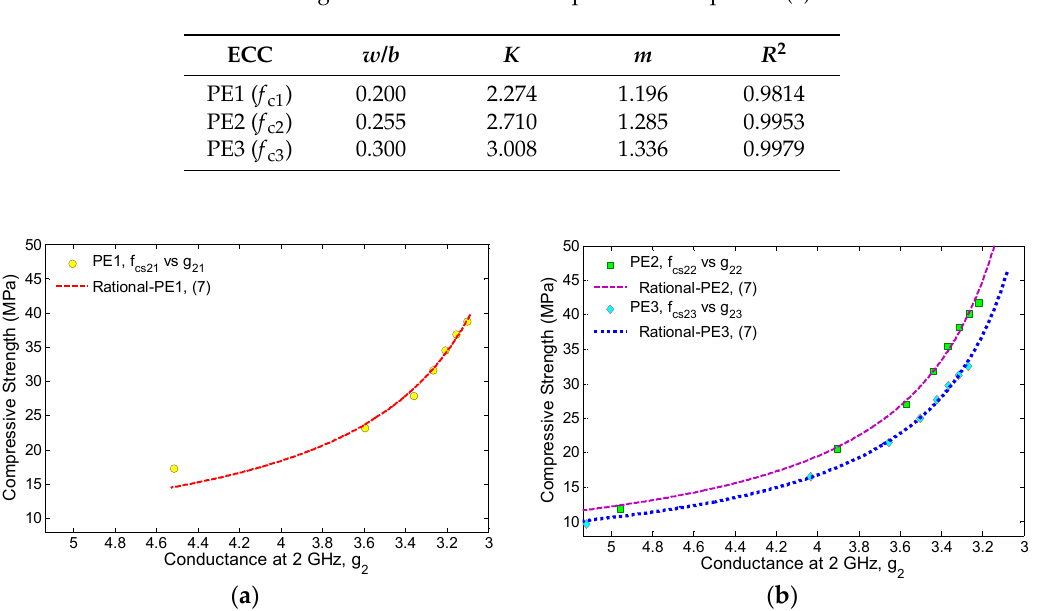
Figure 13. ( a ) S ‐ C correlation for PE1 ( w / b = 0.20) specimen; ( b ) S ‐ C correlations for PE2 ( w / b = 0.255) Figure 13. ( a ) S-C correlation for PE1 ( w / b = 0.20) specimen; ( b ) S-C correlations for PE2 ( w / b = 0.255) and PE3 ( w / b = 0.30) specimens. and PE3 ( w / b = 0.30)